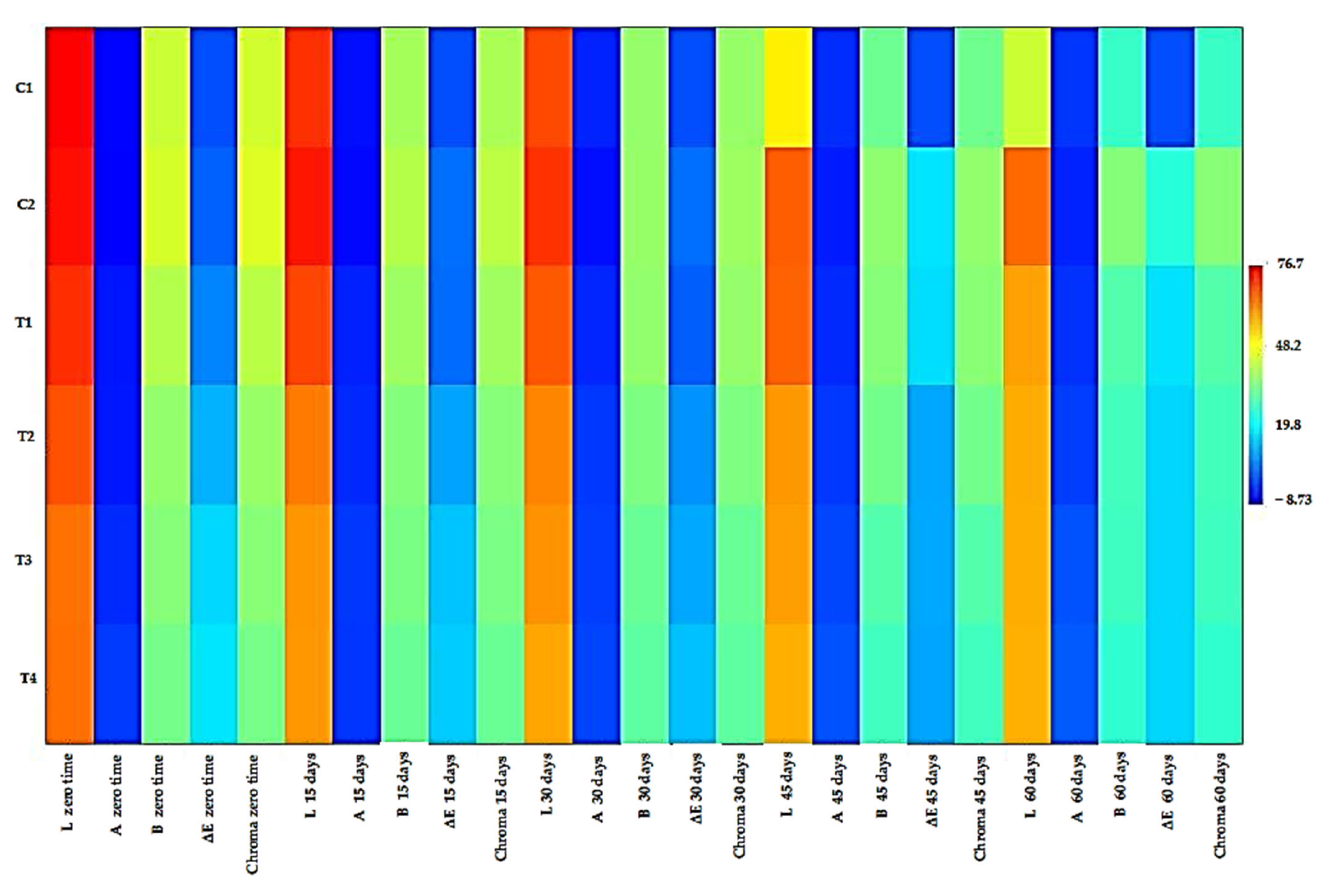
Figure 4. The photographs of control and RCFE-enriched mayonnaise samples. C1, mayonnaise with no antioxidants; C2, mayonnaise treated by 0.02% BHT; T1, T2, T3, T4: mayonnaise treated by